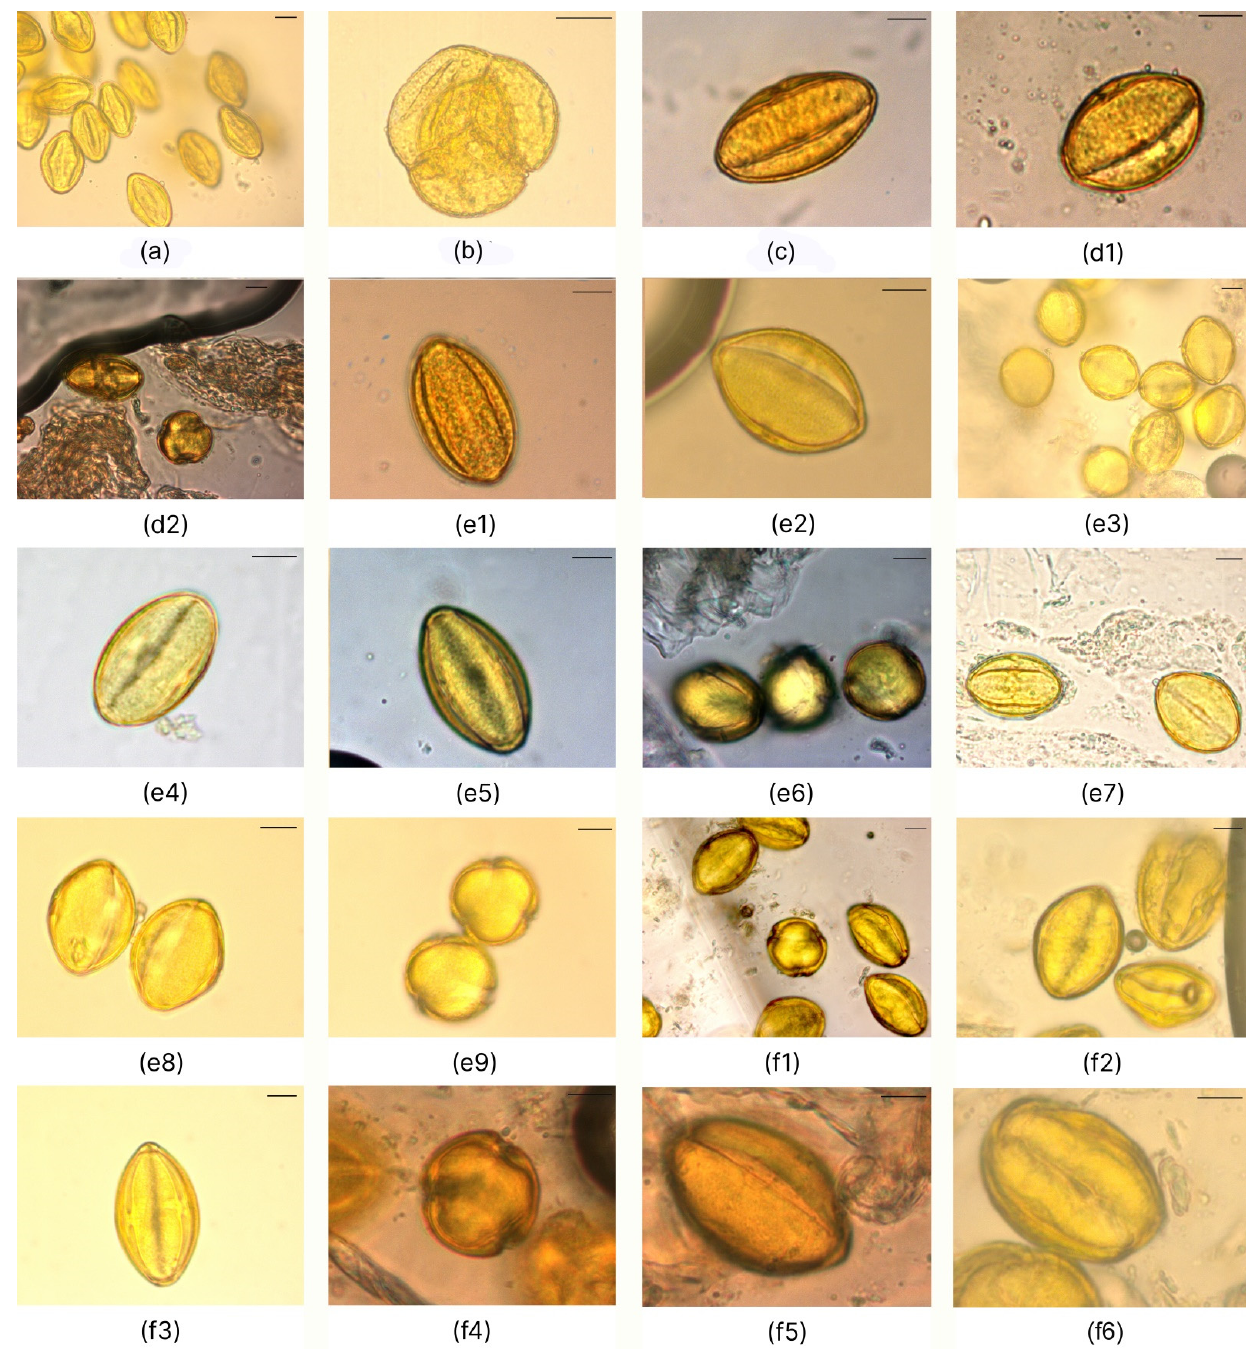
Figure 1. LM micrographs of Nitraria pollen: ( a ) equatorial view for N. komarovii ; ( b ) polar view for N. pamirica ; ( c ) equatorial view in the mesocolpus area of N. tangutorum ; ( d1 ) equatorial view in the mesocolpus area of N. praevisa ; ( d2 ) semipolar view for N. praevisa ; ( e1 – e9 ) N. sibirica specimens from ( e1 ) Balansor, ( e2 ) Balhash, ( e3 ) Basshi, ( e4 ) Dauria, ( e5,e6 ) Kosh-Agach, ( e7 ) Shelek, and ( e8 , e9 ) Kurti; ( f1 – f5 ) N. schoberi specimens from ( f1 ) Balhash, ( f2 ) Karatal, ( f3 ) Malinovoe, ( f4 , f5 ) Sariozek, and ( f6 ) Taskarasu. Bar: 10 μ m.